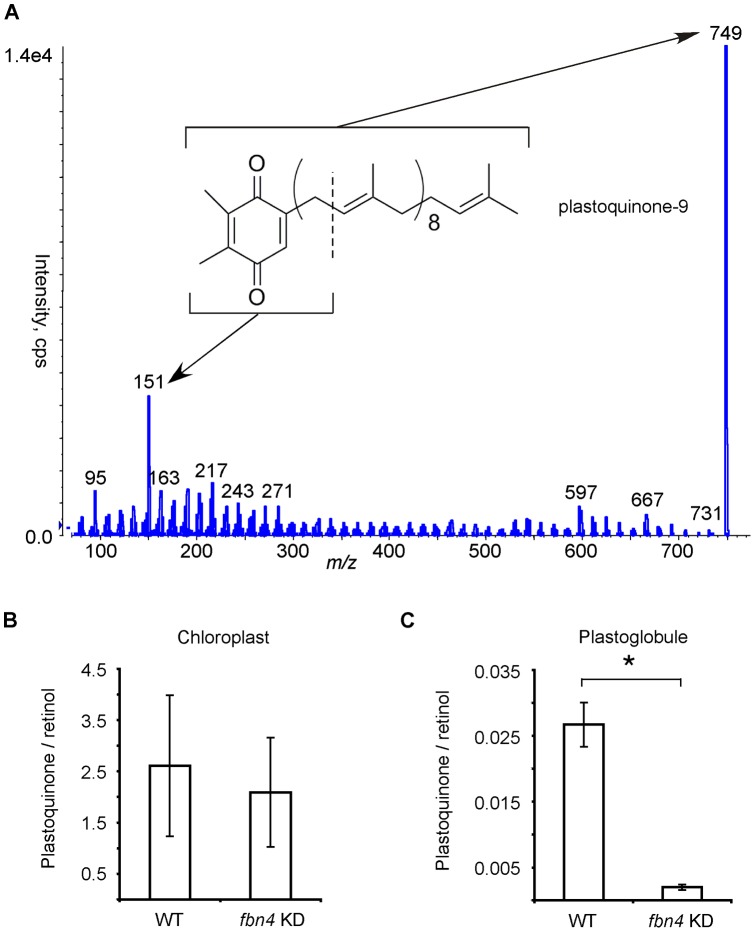
Analyte at m/z 749.(A) MS/MS analysis and possible structure. Abundance in WT and fbn4 KD lipid extracts from chloroplasts (B) and plastoglobules (C), normalized to retinol. Data are means ± SD of three measurements; *, P<0.05 using Student's t test. Similar results were obtained in two biological replicates for the chloroplasts and three biological replicates for the plastoglobules.